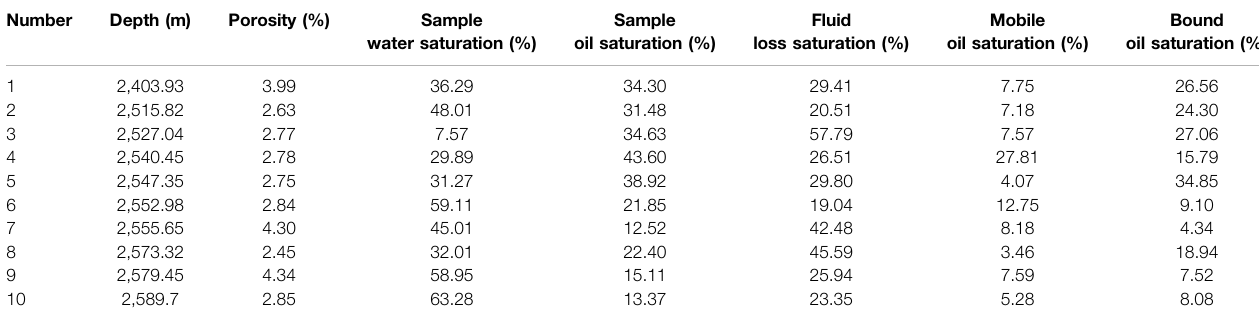
TABLE 10 | Experiment results of saturation of shale oil fl uids.